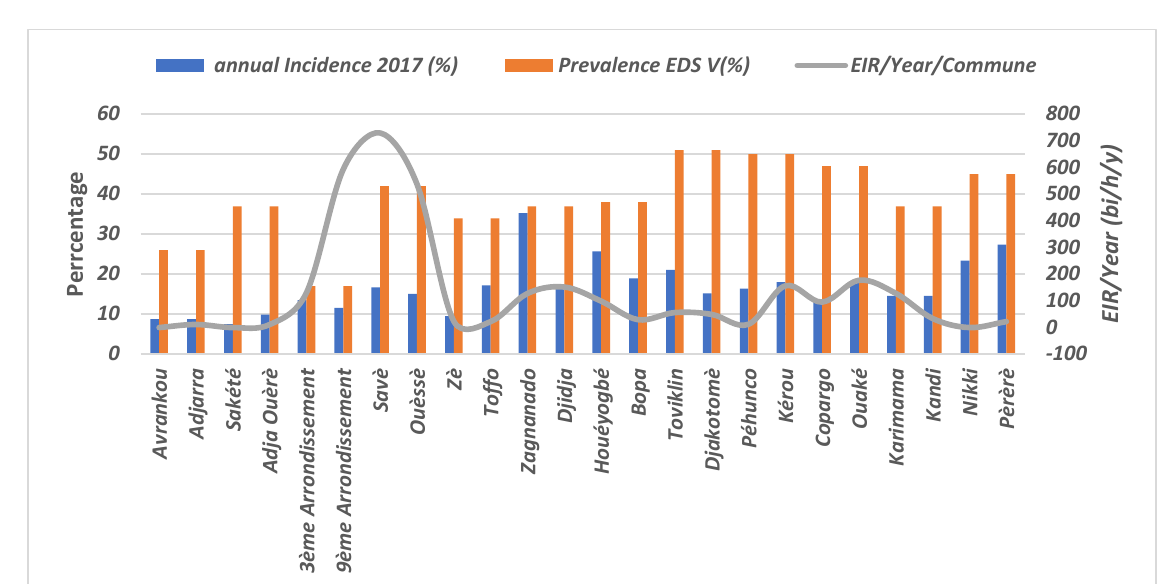
and Djidja in Zou; and in the departments of Mono and Couffo, all three metrics were consistent with one another.